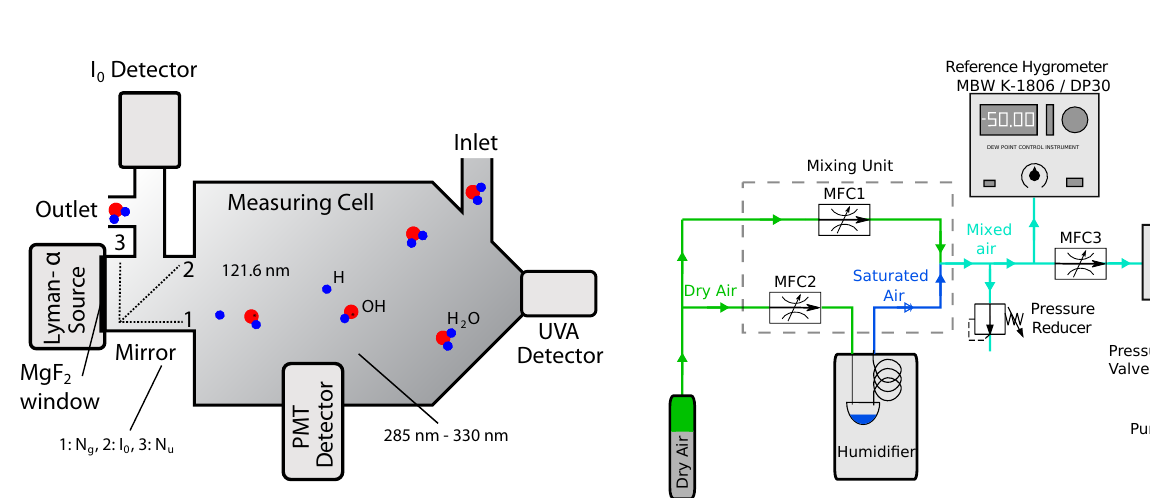
Figure 1. FISH (Fast In-situ Stratospheric Hygrometer) map of 348 aircraft flights. The “fish cloud” is in memory of our colleague Cornelius Schiller – see also dedication at the end of the paper.